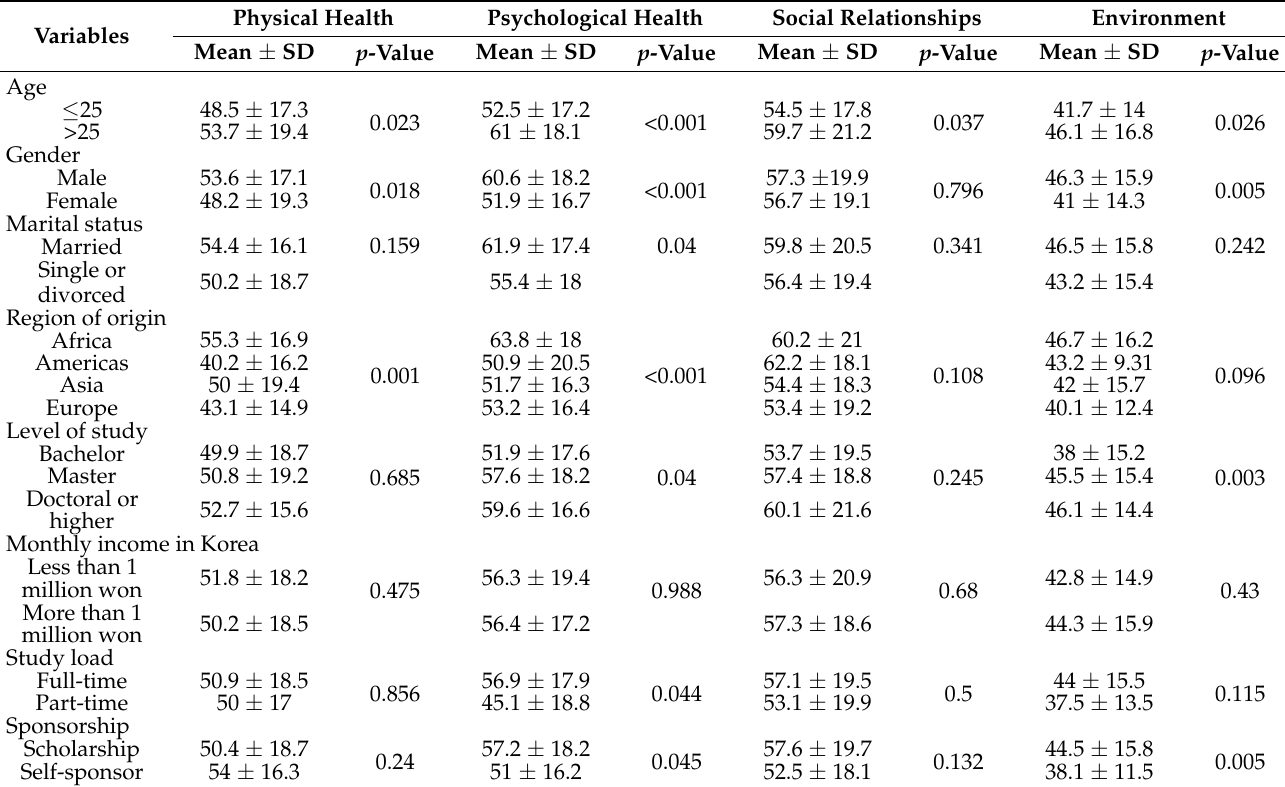
Table 2. QoL domain scores according to sociodemographic